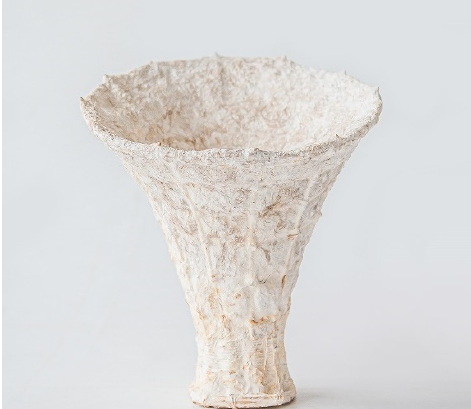
Figure 14. Final Prototype.